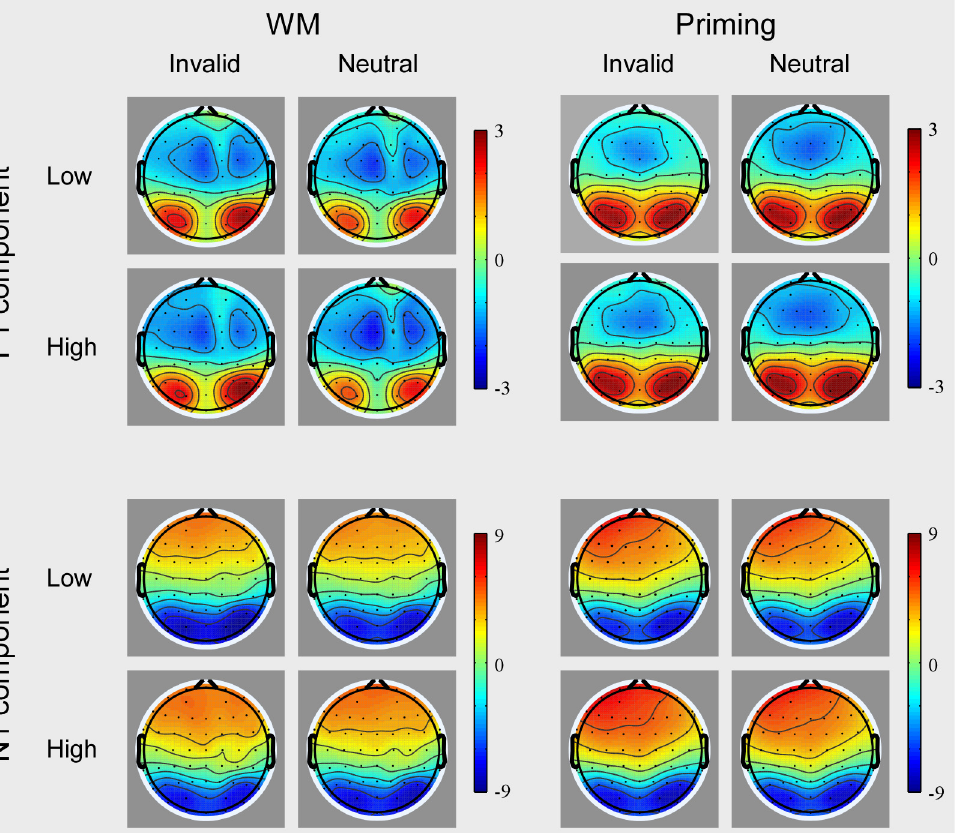
Fig 5. The scalp voltage distribution maps of the P1 (upper panels) and N1 (lower panels) component as a function of perceptual load and validity when the cue was held in WM (left column) and when it was merely identified (right column). The time points of the P1 and N1 components were 80 – 120 ms and 150 – 190 ms both in the WM group and the mere-repeat group, respectively. The color bars show the voltage value (in μ V) of the component.